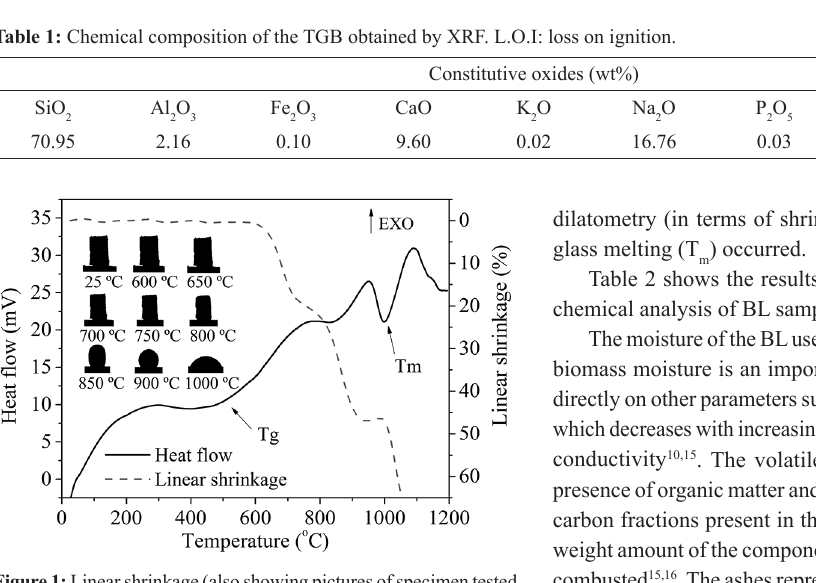
Table 2: Proximate chemical and elemental analysis of banana leaf (BL)